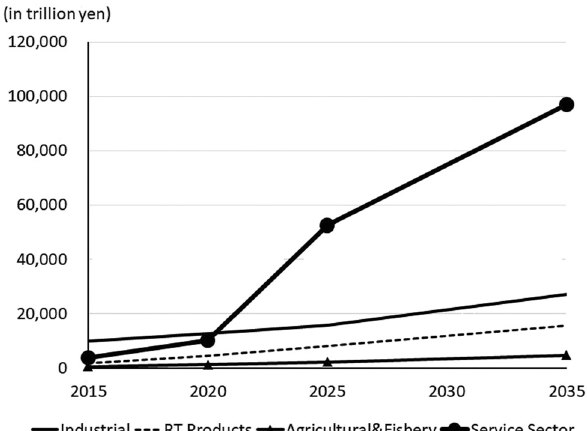
Figure 1: A projection of robot industry in Japan ( NEDO 2010 )